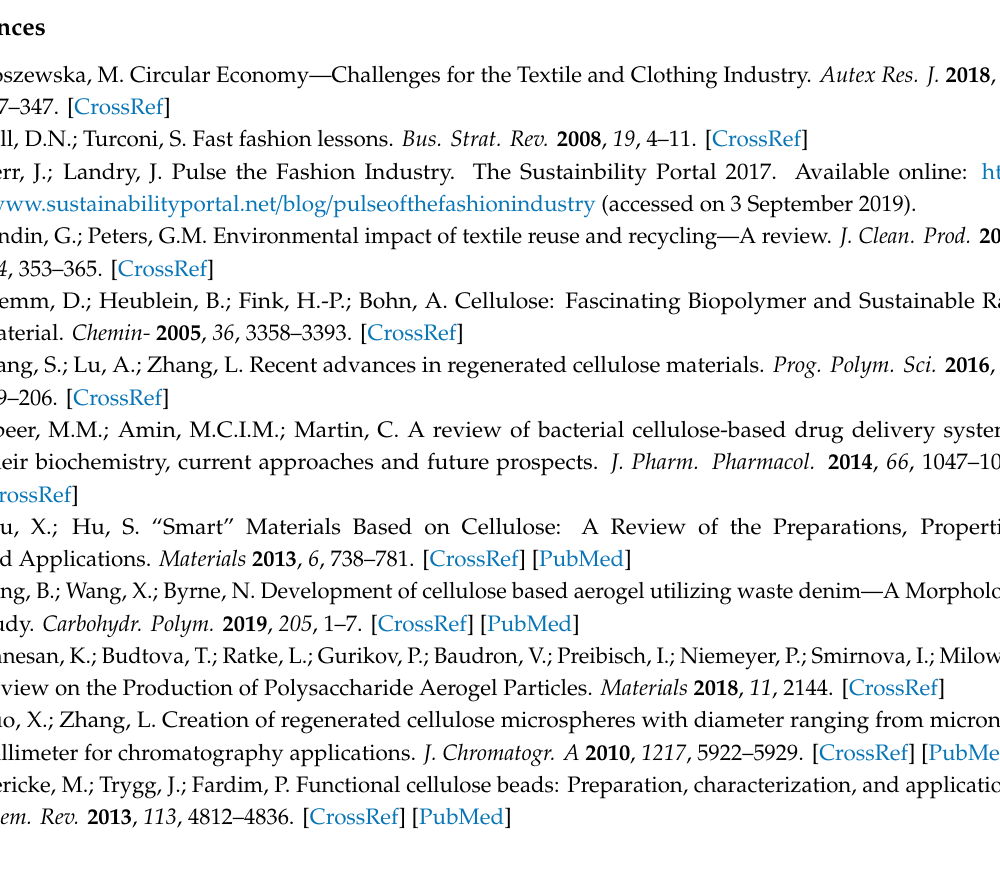
Figure S1: The standard concentration curve of LiHCl; Figure S2: standard concentration curve of Thp; Figure S3: rheological curves of denim-BmimCl and denim-BmimAc solutions at room temperature; Figure S4: Schematic explanation of cellulose mobility with two ILs; Figure S5: Pore size distributions of beads analysed from N 2 physisorption. Table S1: loading capacities of LiHCl and Thp in the three types of